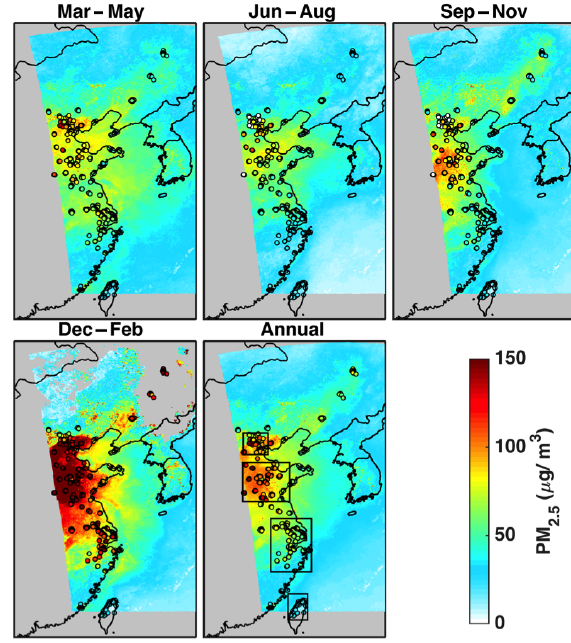
Figure 3. Seasonal and annual distribution of PM 2 . 5 concentrations at 6km by 6km resolution over East Asia for 2013. The background color indicates averages of GOCI-derived daily surface PM 2 . 5 con- centrations. Filled circles represent averages of daily ground-based measurements of PM 2 . 5 . Gray denotes missing values. Boxes in the annual map denote regions used for monthly comparisons in Fig. 5 from top to bottom: Beijing and surrounding areas, Shandong and surrounding regions, Shanghai and surrounding areas and northern